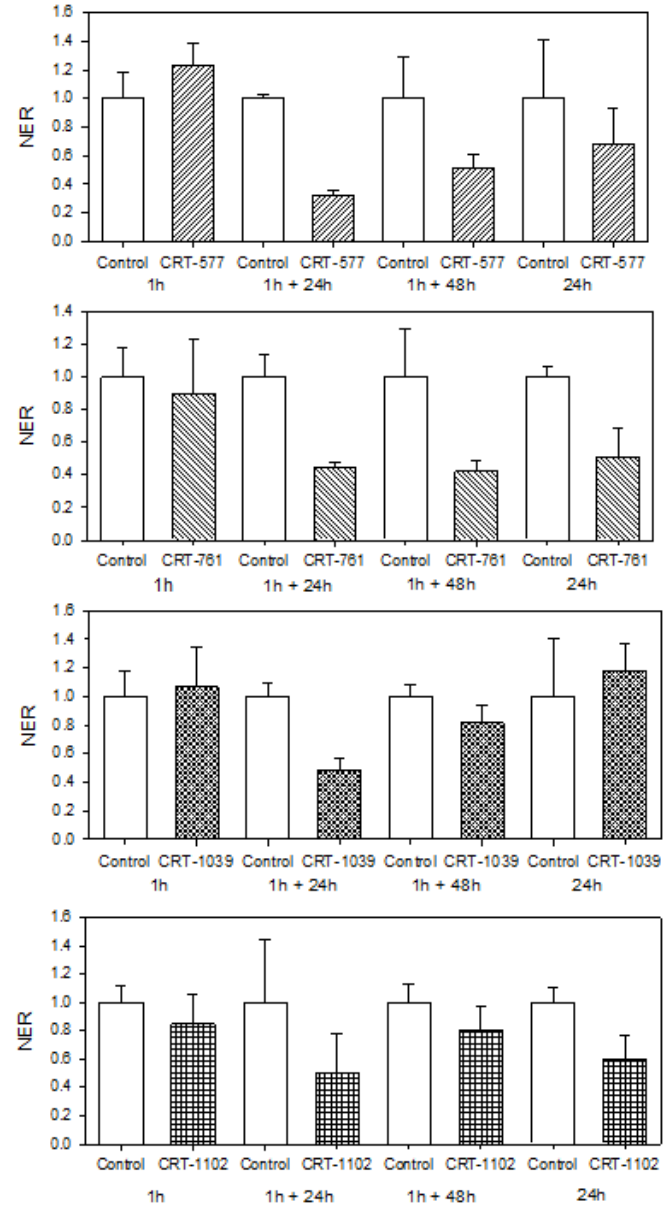
Figure 3. Efficiency of Mi-CRT silencing varies upon siRNA triggers. Normalized expression rate (NER) of Mi-CRT after soaking J2s for 1 hour or 24 hours in siRNA CRT-577, CRT-761, CRT-1039 or CRT-1102 followed by 0, 24 or 48 hours incubation in water. The relative quantity of Mi-CRT transcripts was quantified by Reverse Transcription-quantitative PCR using GAPDH (Minc10963 and Minc12412) and actin (Minc06769 and Minc06773) genes as reference genes. For controls, J2s were soaked